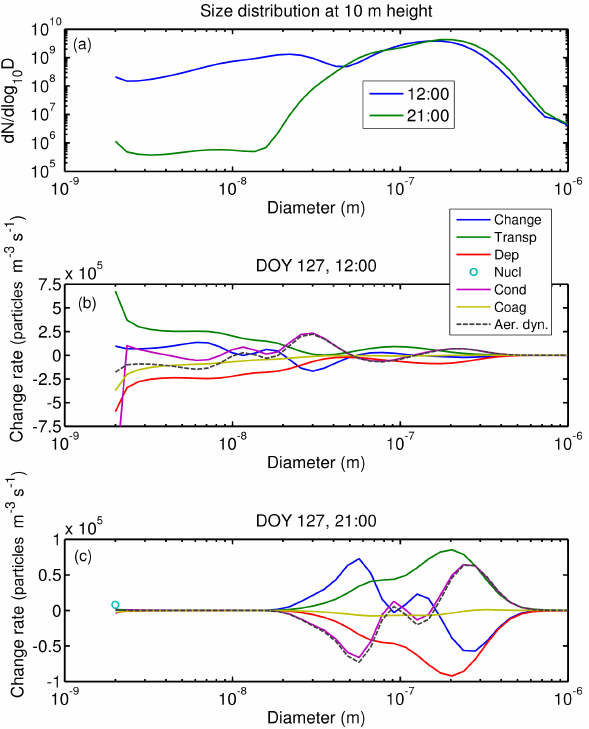
Figure 3. (a) Aerosol size distributions and the conservation terms on 7 May at (b) 12:00LT (the values for nucleation and condensa- tion terms at 2nm are out of scale, being in absolute values about 1 . 3 × 10 6 particlesm 3 s − 1 but opposite in sign) and (c) 21:00LT as a function of particle size at 10m height. The storage change (Change), (vertical) transport (Transp), particle deposition (Dep) and aerosol dynamical (Aer. Dyn.) terms are also used in Eq. (4). The aerosol dynamical term is the sum of the nucleation (Nucl), condensation growth (Cond) and coagulation (Coag)